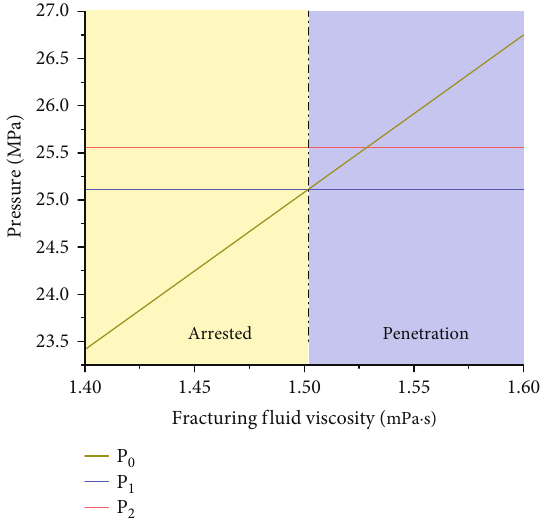
Figure 7: Changes in P